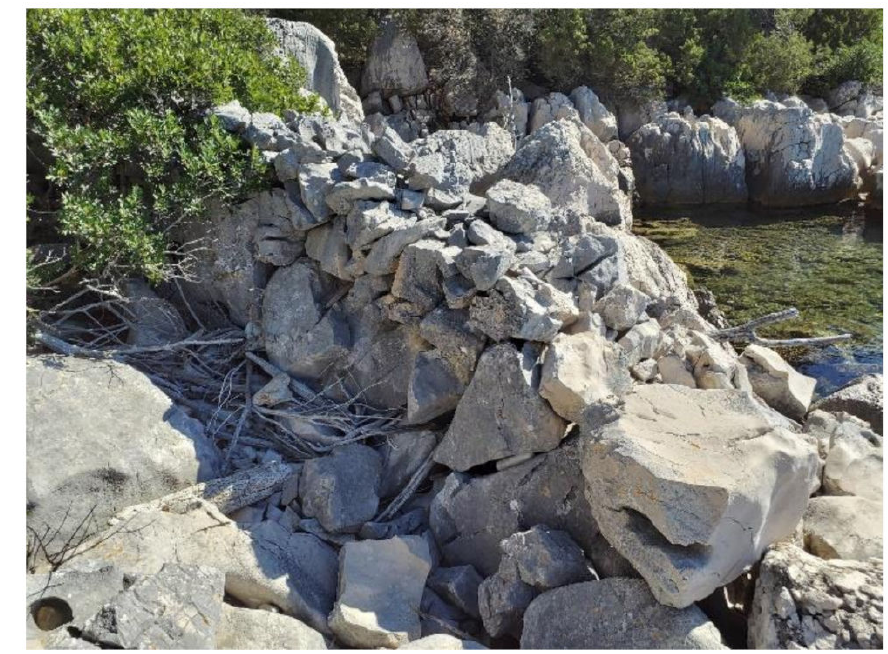
Figure 35. Bounding wall photographed at the point where it meets the coastline. The wall is depicted on the 1821 Franciscan map and remained in use until recently (Photo: M. Doneus, 1 September